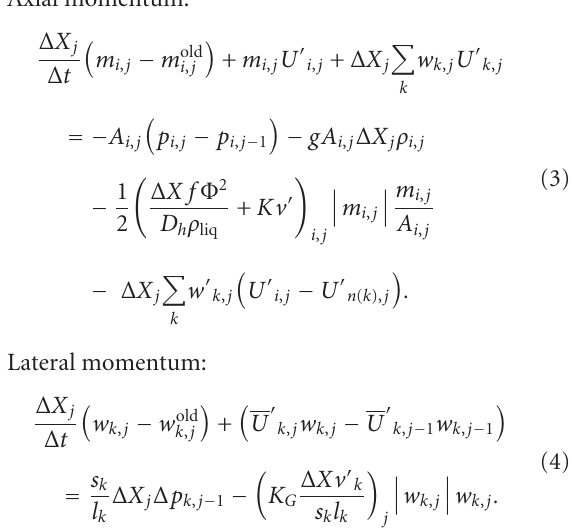
Table 1: Boundary conditions for single channel tests.